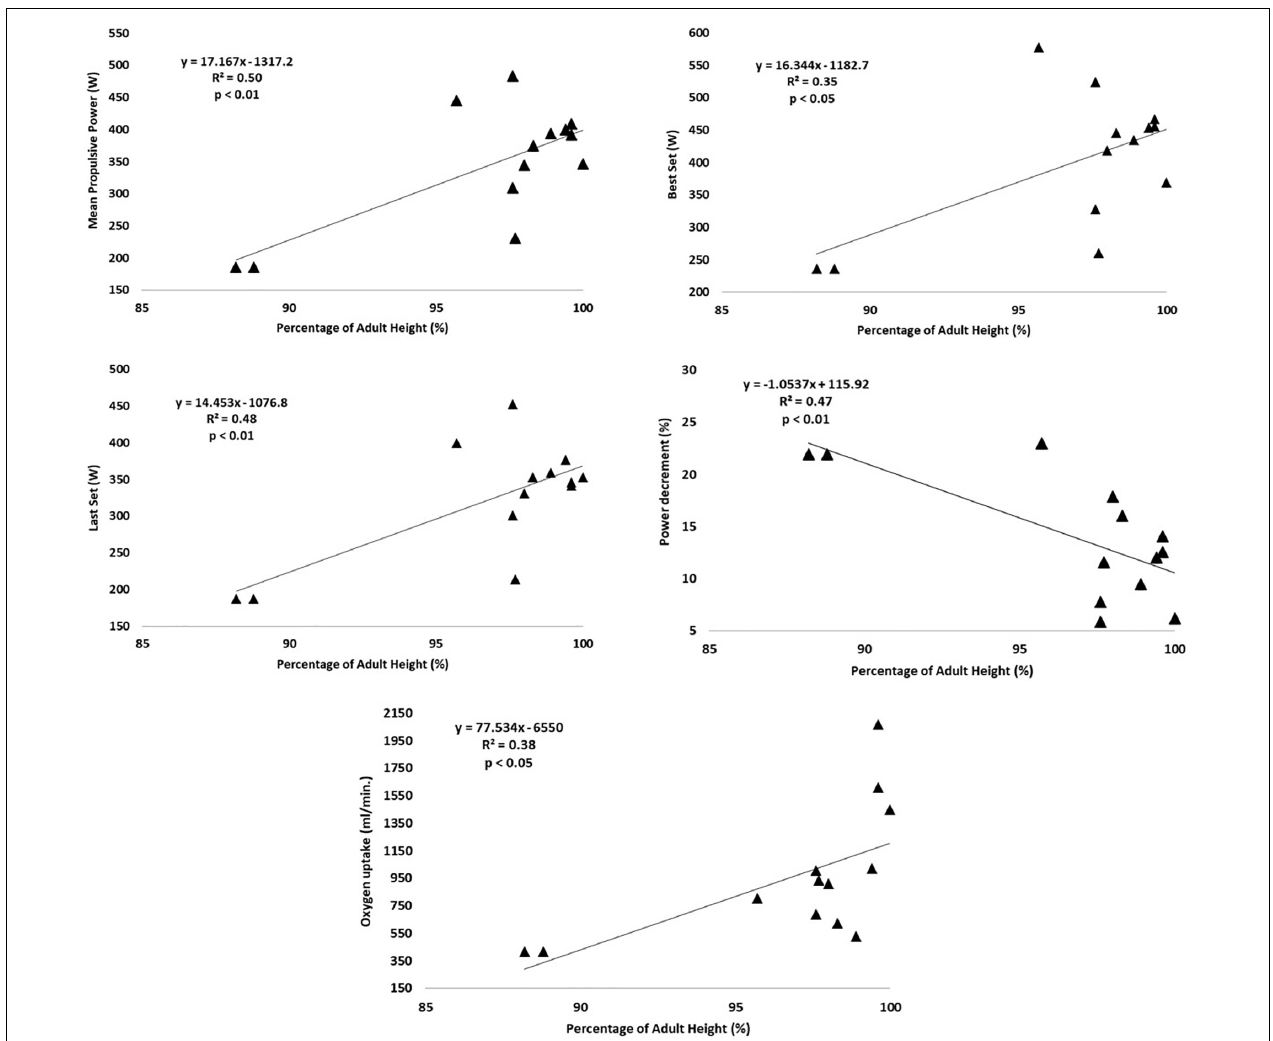
FIGURE 1 | Linear relationship between (A) Mean Propulsive Power and% PAH, (B) Best Set and% PAH, (C) Last Set and% PAH, (D) Power decrement and% PAH, and (E) Oxygen uptake and%